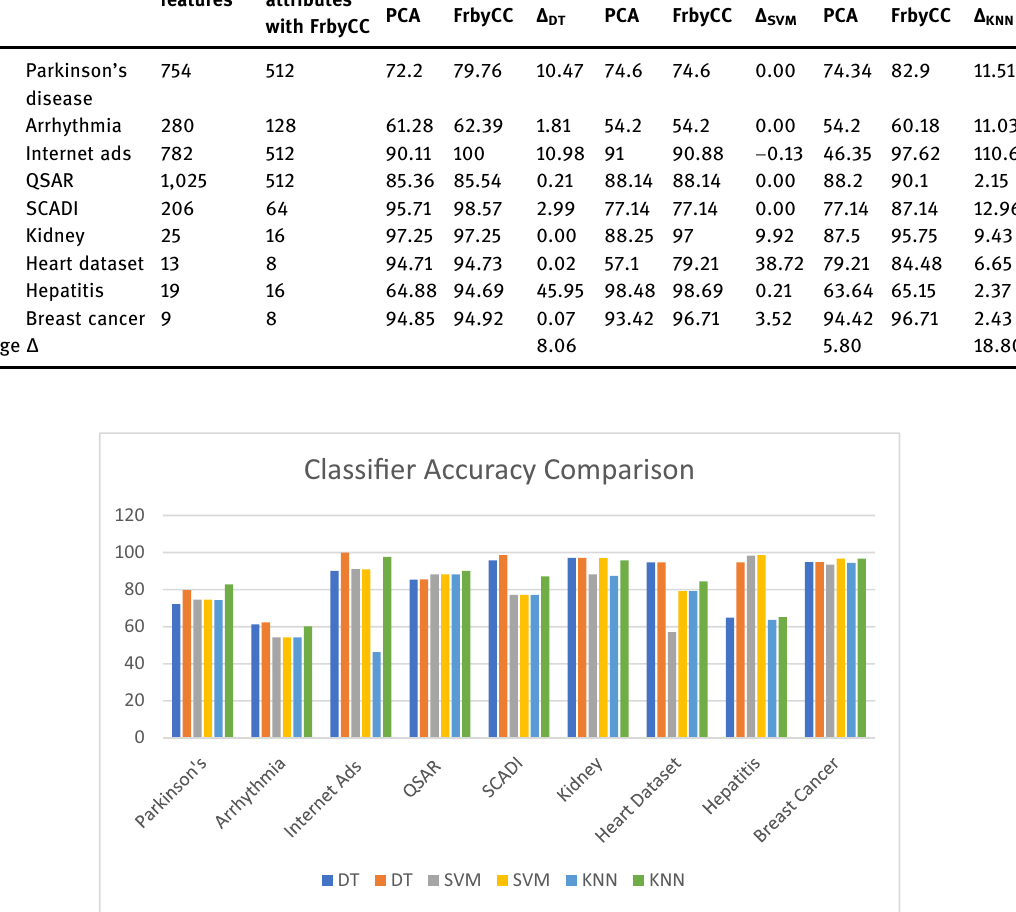
Table 6: Accuracy of FrbyCC and PCA method with DT, KNN, and SVM classi fi er Sr. No. Dataset